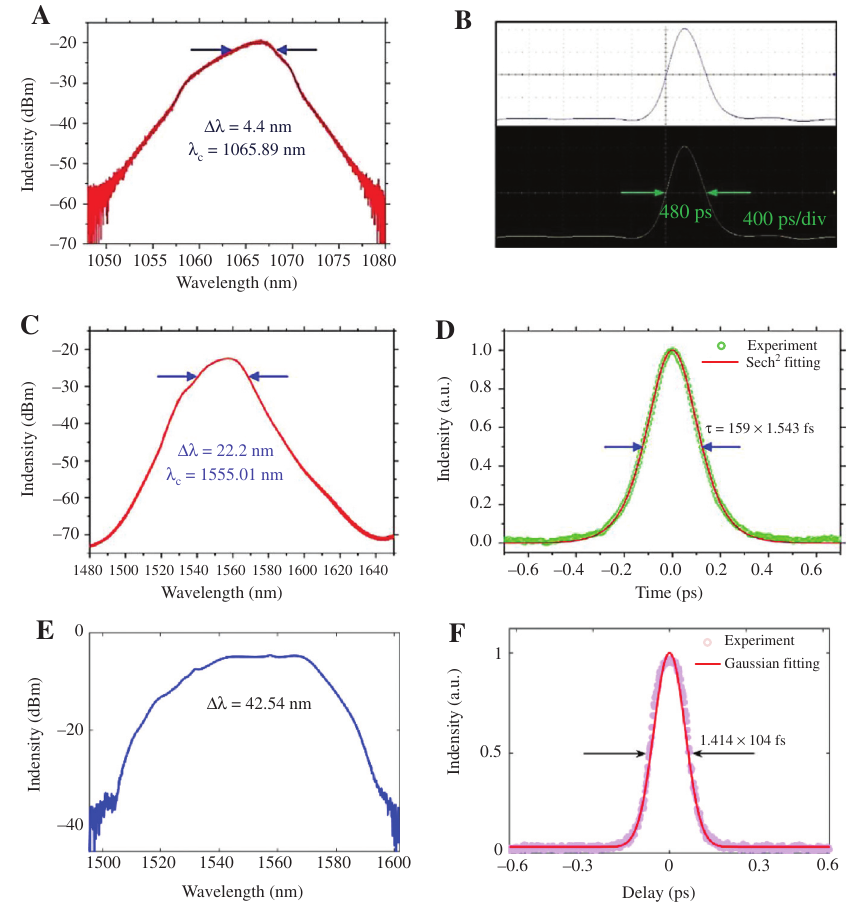
Figure 6: Mode-locked results enabled by MXene-based SAs. (A) Spectrum and (B) pulse profile in Yb-doped fiber laser. (C) Spectrum and (D) autocorrelation trace in Er-doped fiber laser. (E) Spectrum and (F) autocorrelation trace in a dispersion-managed fiber laser. (A)–(D) are reproduced with permission from Ref. [186]. Copyright 2016 Wiley-VCH Publishing. (E) and (F) are reproduced with permission from Ref. [189]. Copyright 2019 OSA